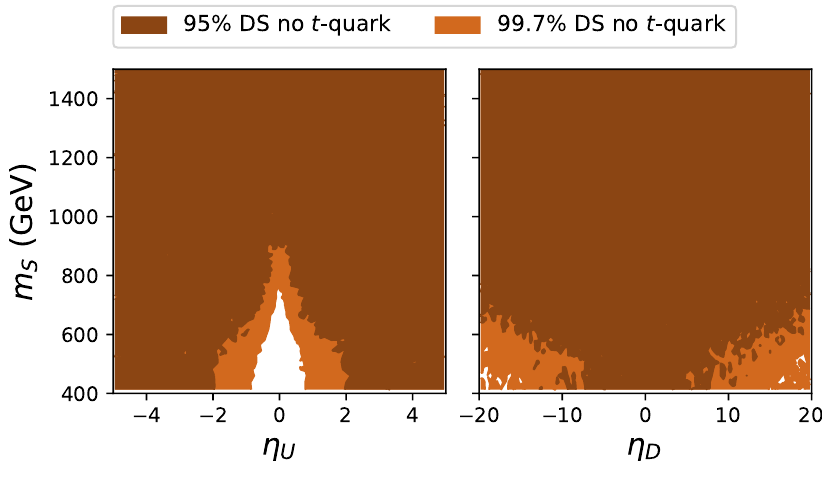
Figure 5 . Constraints on the m S - η U (left) and m S - η D (right) planes, obtained from direct searches in channels without top quarks in the final